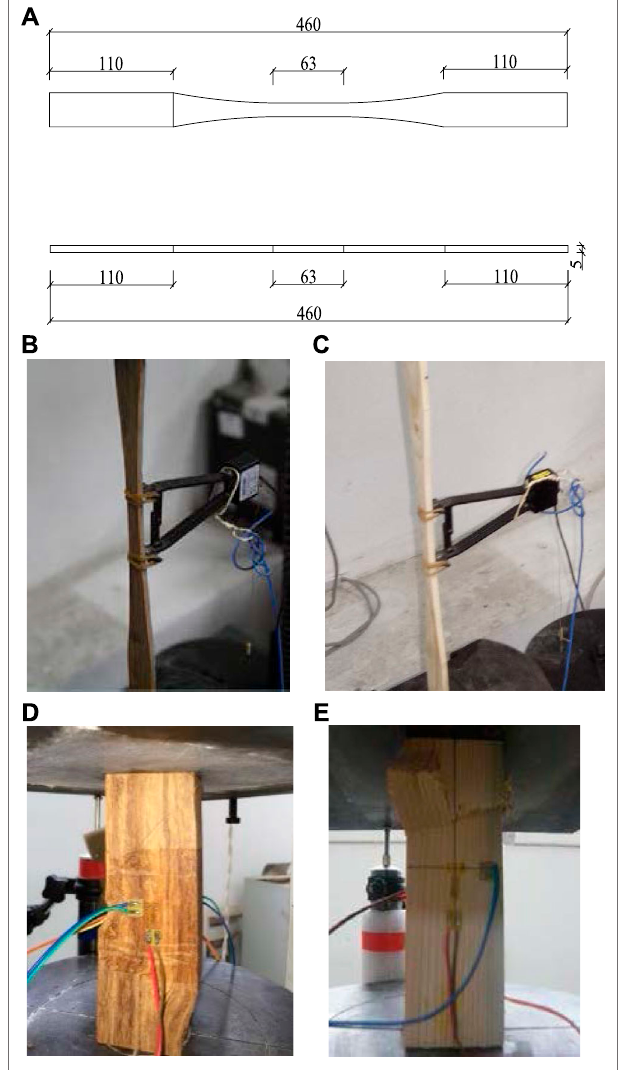
FIGURE 2 | Specimens of bamboo scrimber and wood. (A) Tension specimen size (units: mm). (B) Tension specimen of bamboo scrimber. (C) Tensilespecimensofwood. (D) Compression specimenofbambooscrimber. (E) Compression specimens of wood.